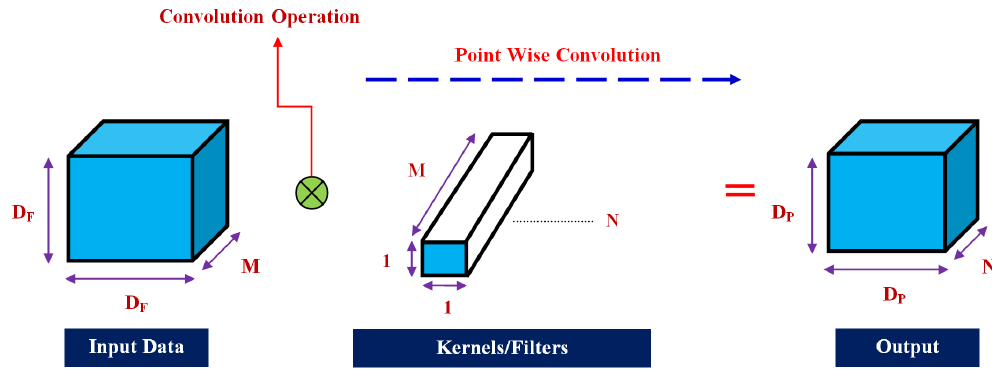
Figure 4. Pointwise